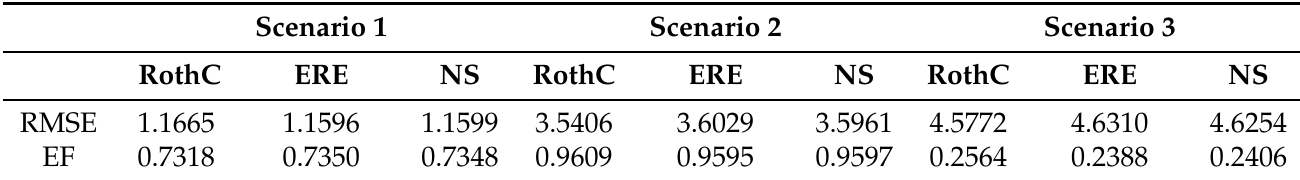
Table 3. RMSE and EF statistical indices for evaluating and comparing the performances of the RothC, ERE and novel non-standard NS